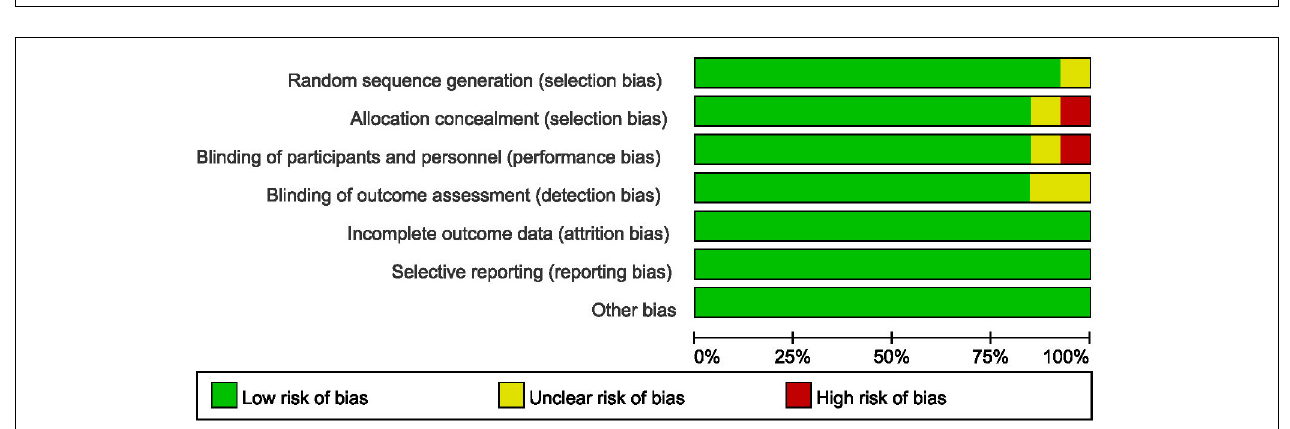
FIGURE 1 | PRISMA flow chart for selection study. CRTs, clinical research trials.